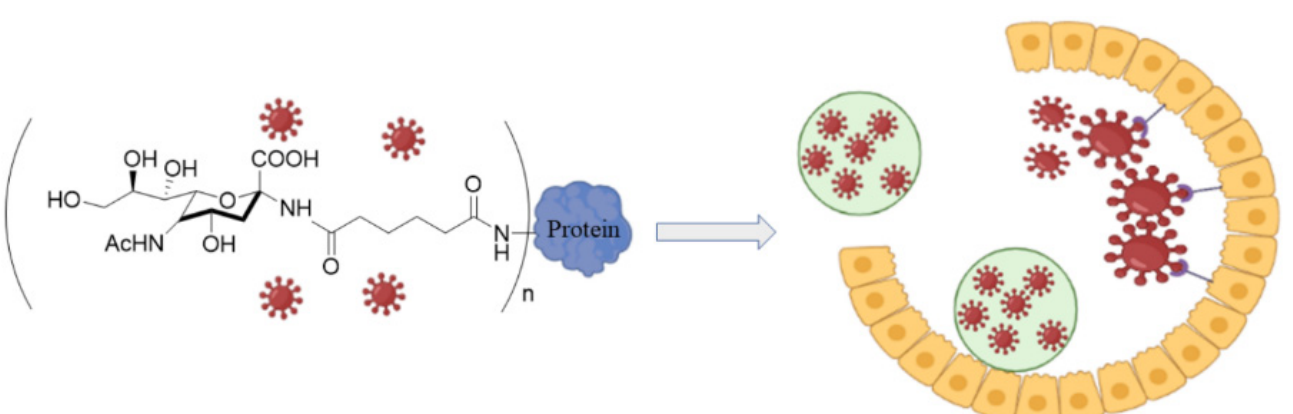
Figure 11. Schematic representation for the clearance of influenza virus by the mucin layer or mucin- mimetic glycol-conjugated proteins prior to uptake by epithelial cells. The image was created by BioRender.com software.